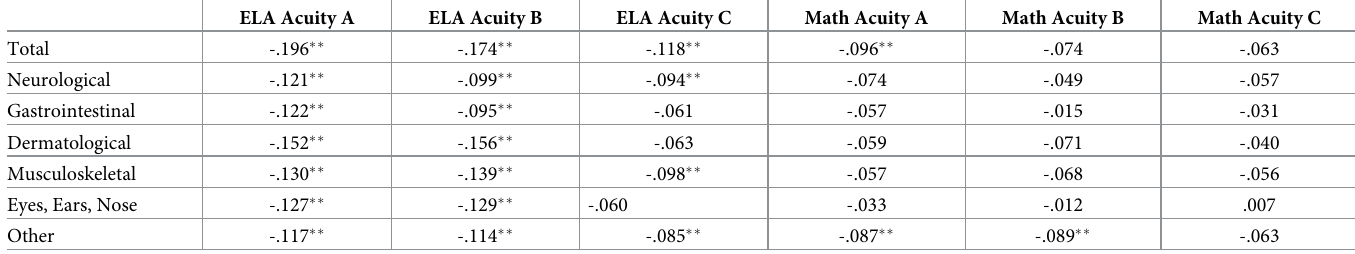
Table 1. Correlations between health data and academic